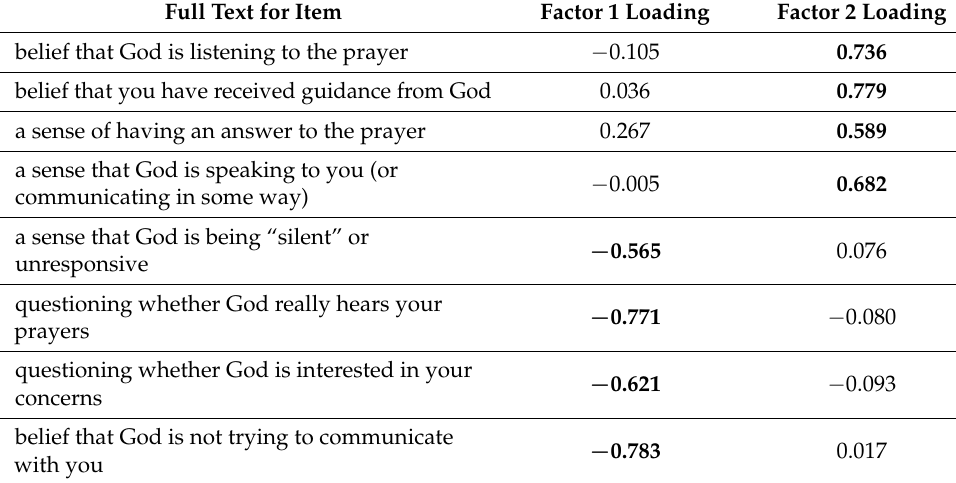
Table 4. Sample 1: Loadings for Exploratory Factor Analysis (EFA) of Proposed Items on Divine Engagement and